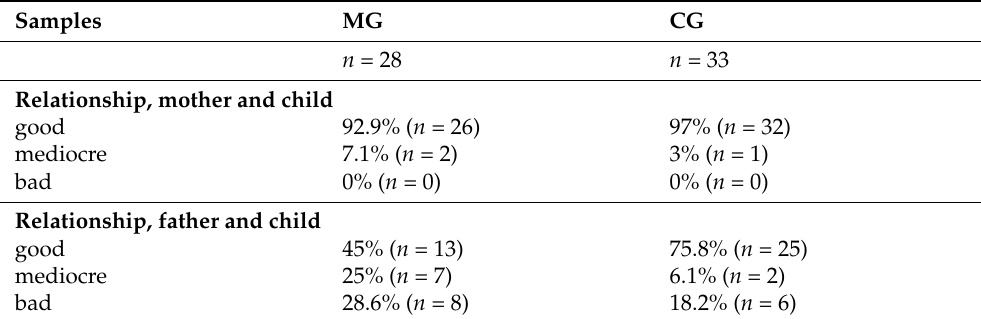
Table 2. Family relationship structure—mother’s perspective; compared between the selective mutism group (MG) and the control group